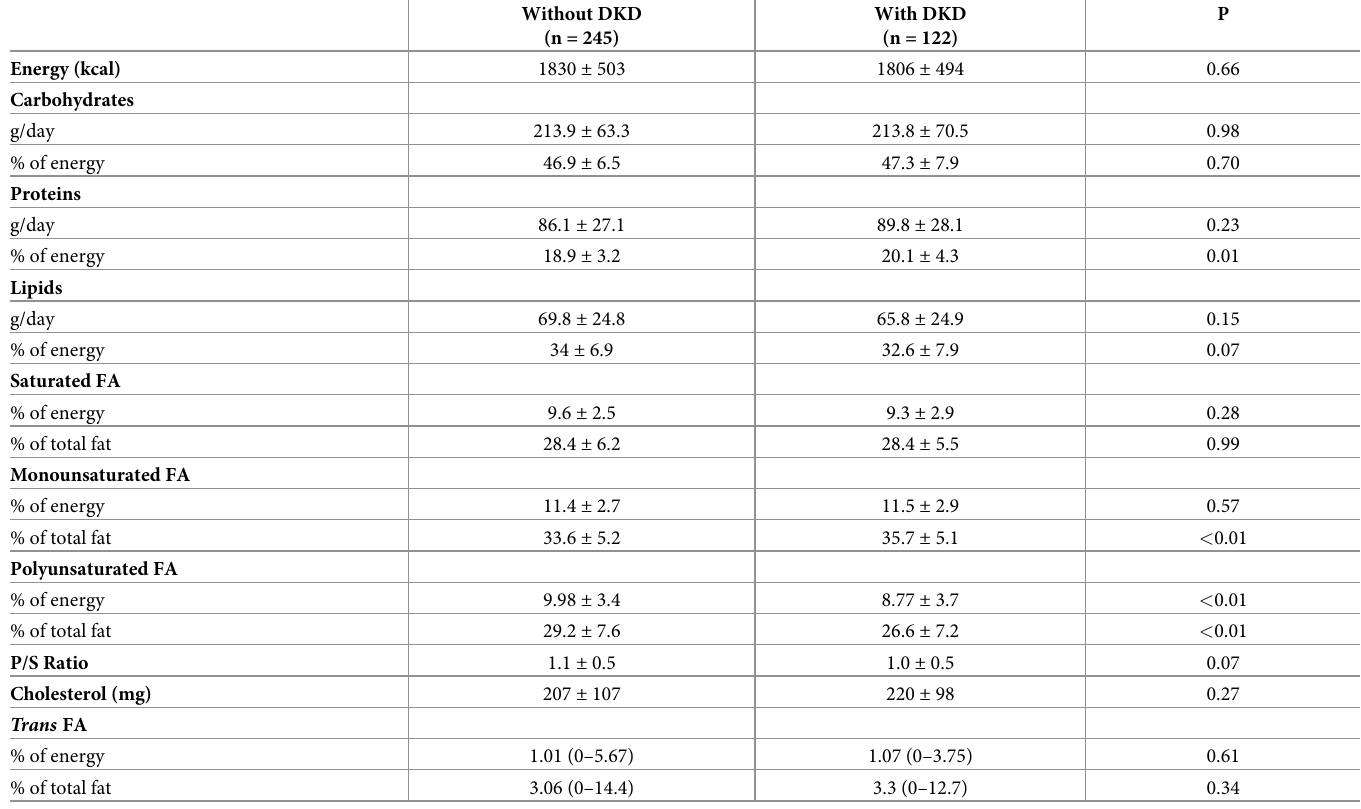
Table 3. Daily dietary intake of patients with type 2 diabetes divided according to the presence or not of diabetic kidney